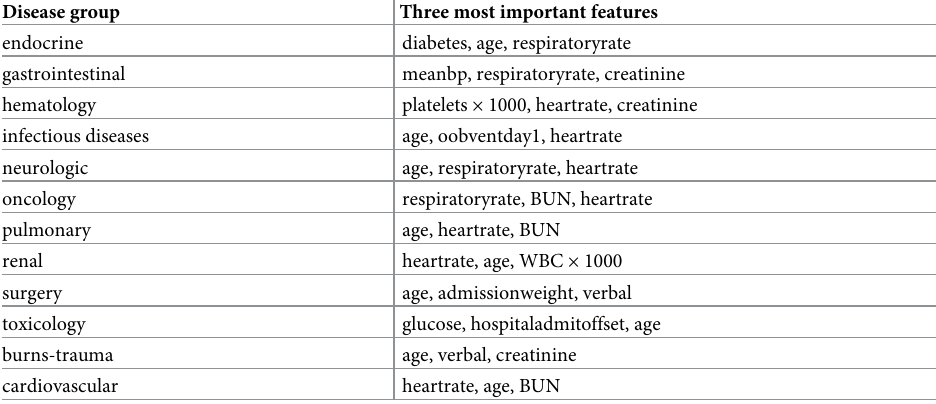
Table 5. Top three most important features in mortality predictions across various disease categories based on Shapley values. Disease group Three most important